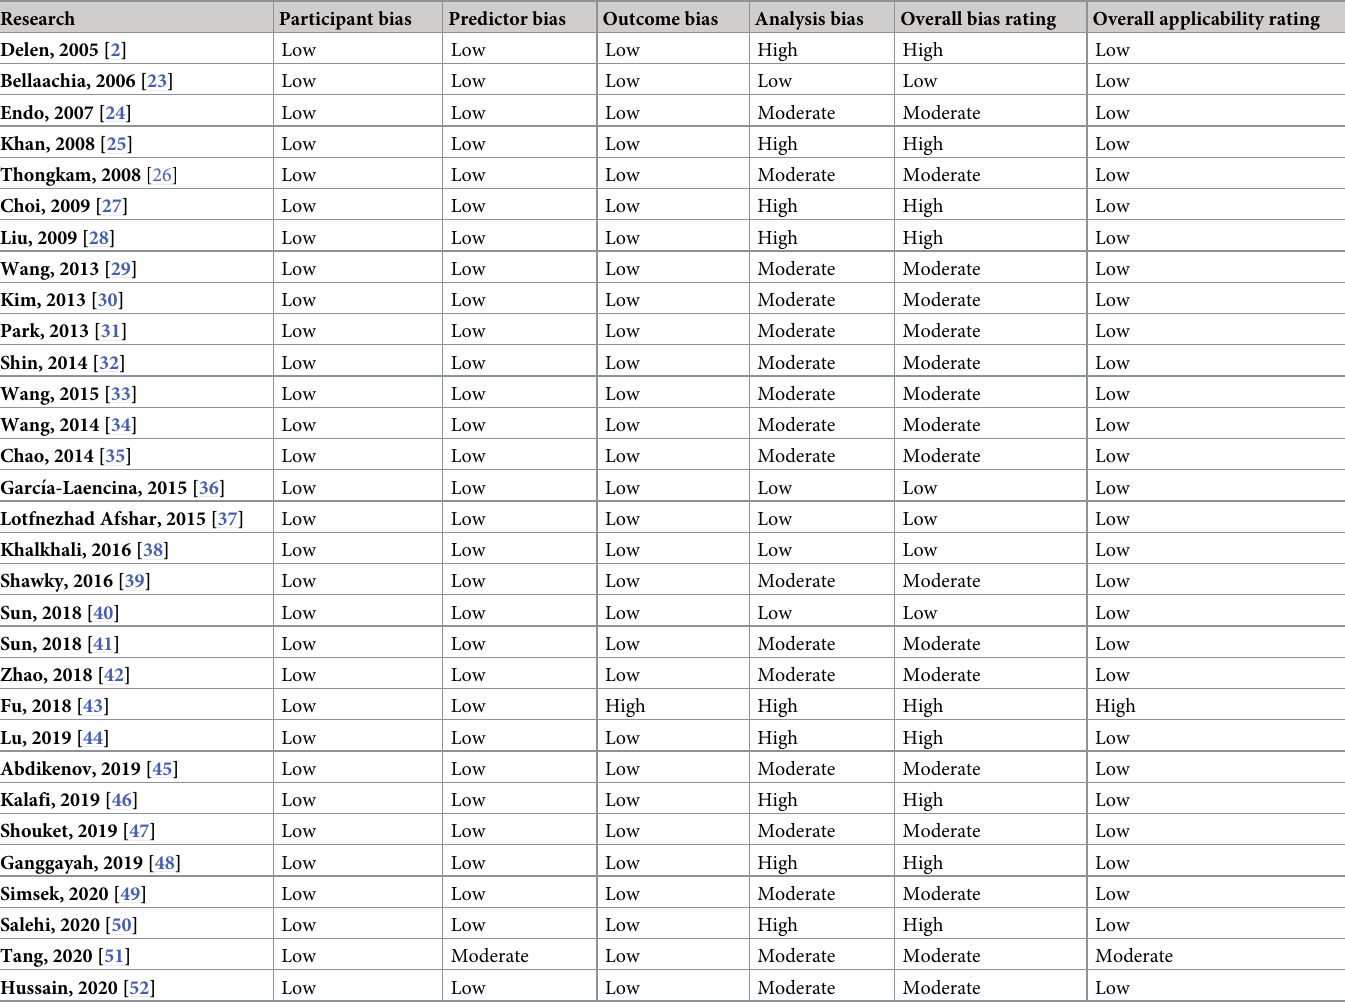
Table 1. Risk of bias and applicability assessment grading of 31 studies as per the PROBAST criteria.